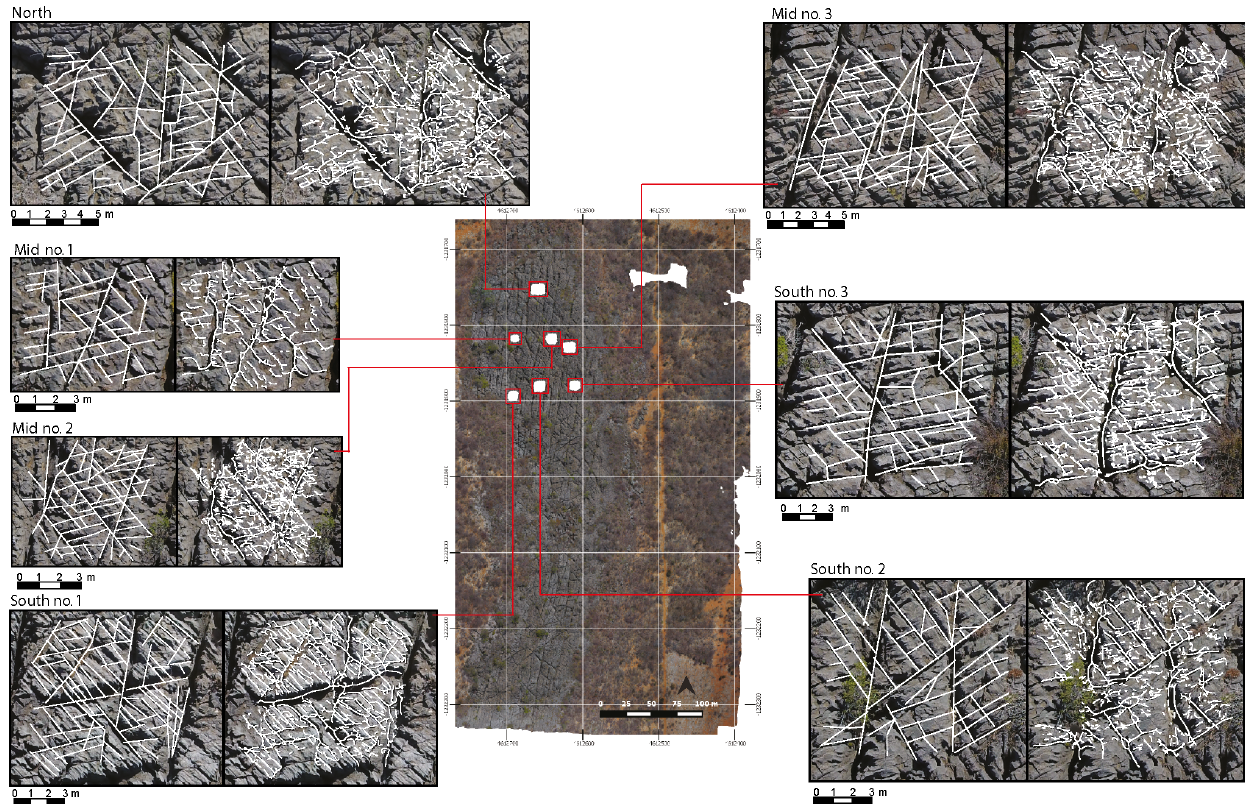
Figure 12. Comparison between manual (left) and automatic (right) interpretation on seven stations within the Brejões outcrop (Prabhakaran et al., 2019a). The manual interpretations were obtained from Boersma et al. (2019). The Brejões dataset (Prabhakaran et al., 2019a) is available under a CC-BY-NC-SA